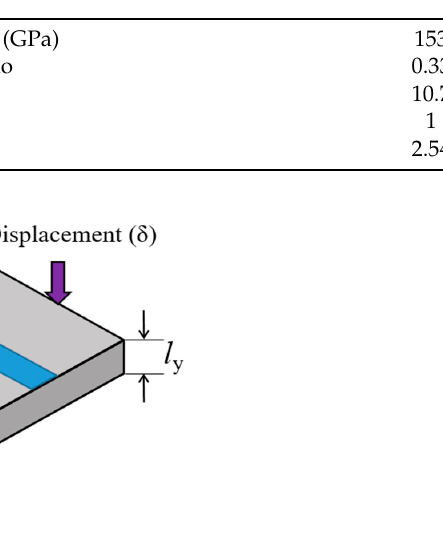
Table 1. Material properties of BST and dimensions of the BST unimorph.